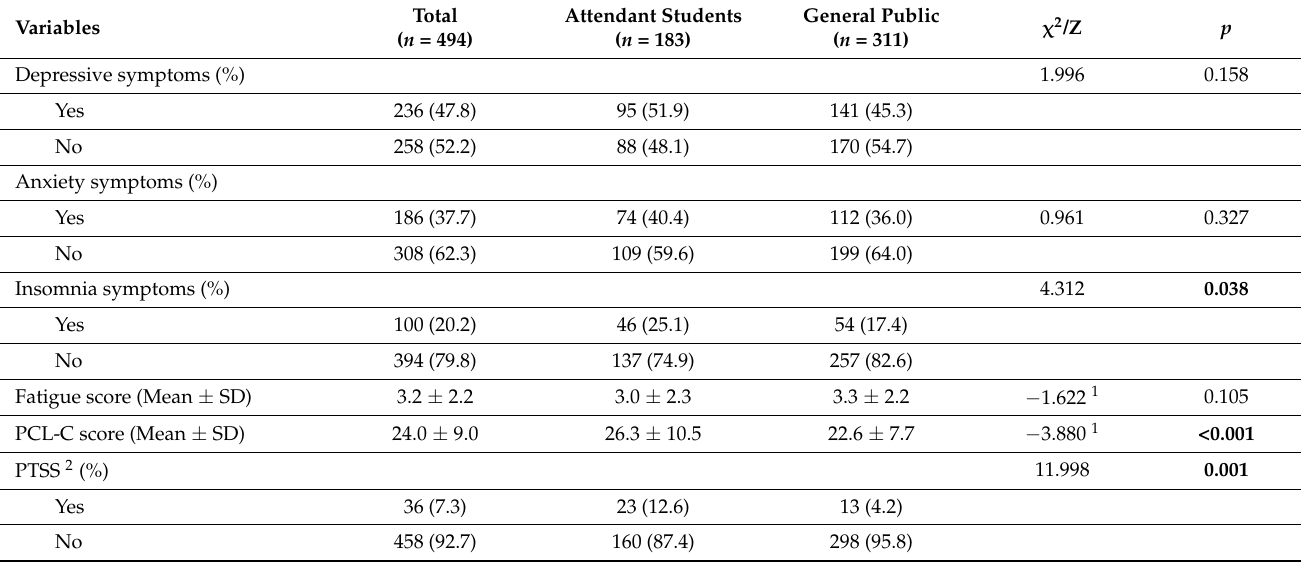
Table 2. Mental health symptoms of participants.